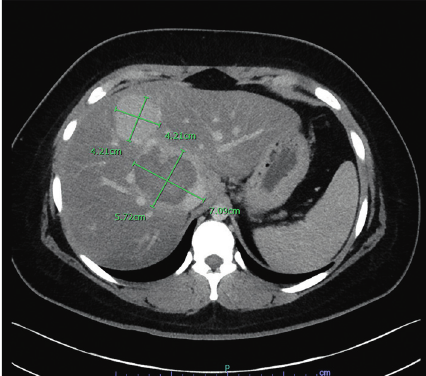
Figure 4: CTscan of the abdomen repeated in two months showing that the dominant HA decreased in size, measuring 7.1 × 5.7cm, with coils and a resolved hemorrhagic component. The non- hemorrhagic mass in segment four decreased to 4.2cm in